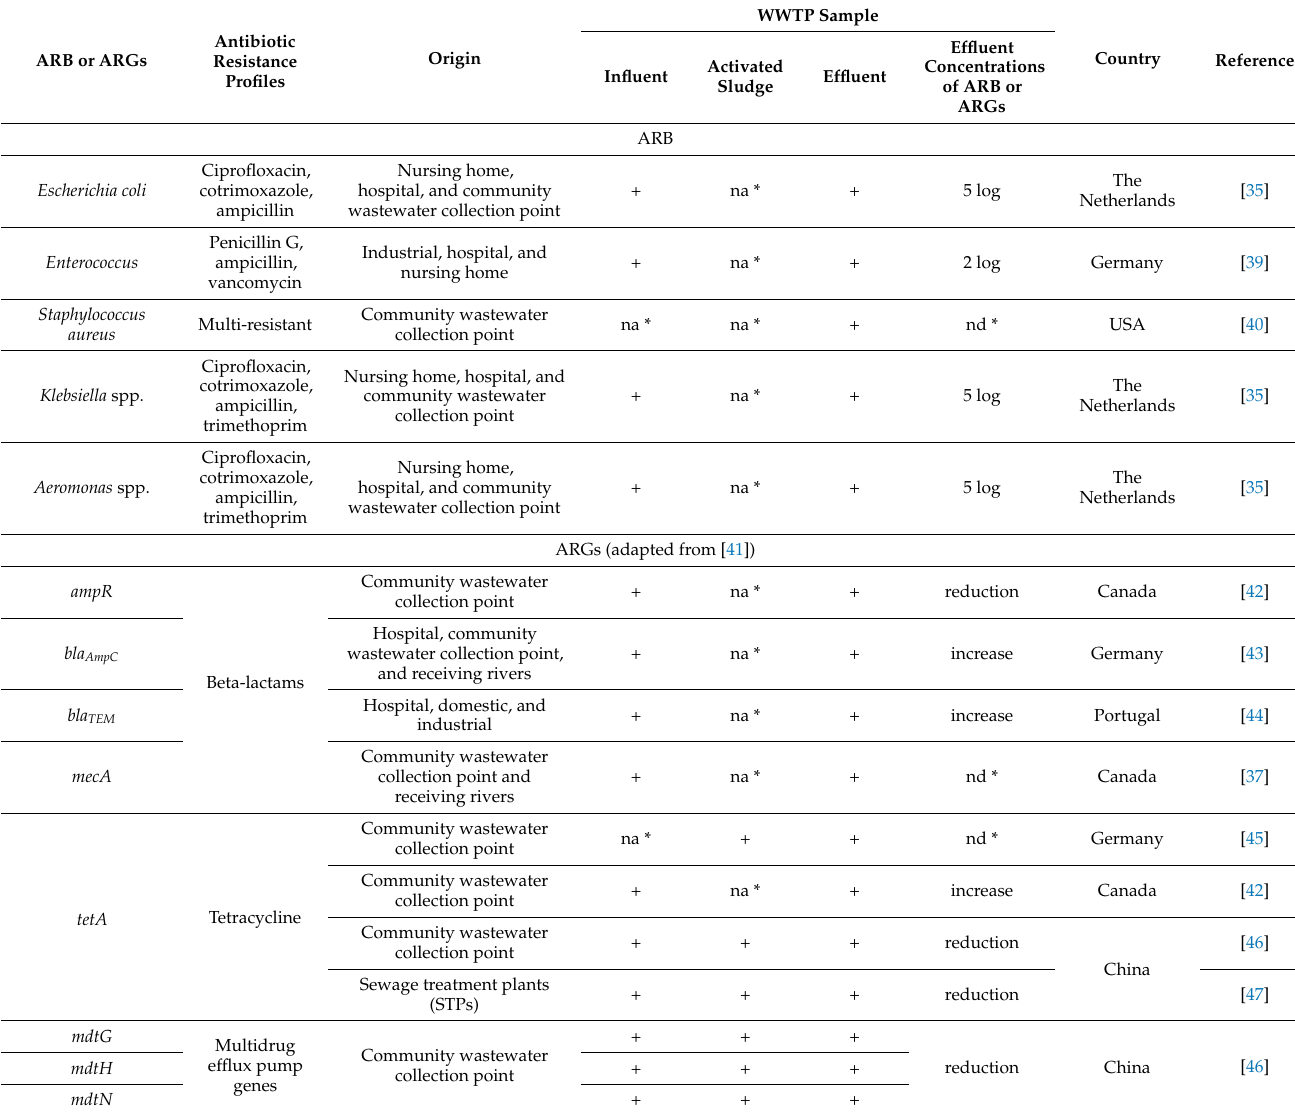
Table 1. Overview of ARB and ARGs found in the influent, effluent, and activated sludge of wastewater treatment plants